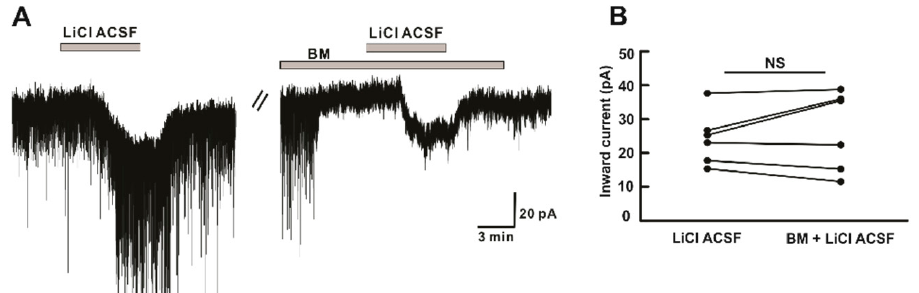
Figure 6. Li + acts on postsynaptic hPOA neurons. ( A ) A representative current trace showing inward currents induced upon perfusion of LiCl ACSF. Li + induced inward current persisted in the presence of BM (blocking mixture), including TTX (Na + channel blocker), picrotoxin (GABA A receptor blocker), strychnine (glycine receptor blocker), CNQX (non-NMDA glutamate receptor antagonist), and AP5 (NMDA receptor antagonist). ( B ) The before and after plot shows no significant difference in the mean inward current between Li + alone and Li + in the presence of blocking mixture ( n = 6, p > 0.05 by the paired t -test). NS, not